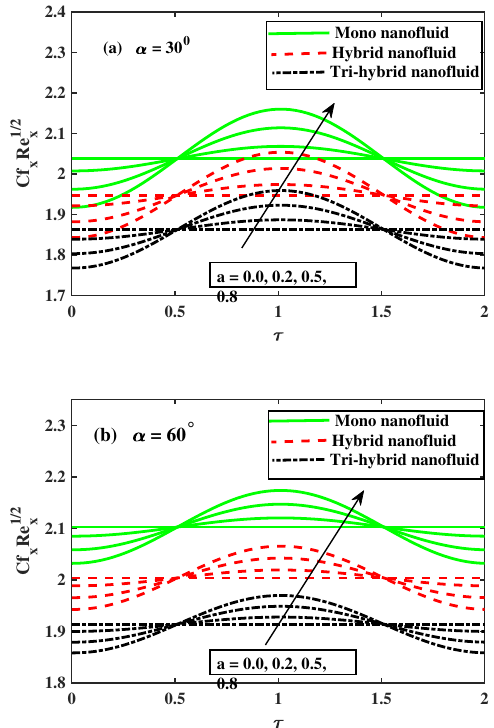
Figure 6. ( a ) Fluctuation of α on Cf x Re 1/2 x ; ( b ) Fluctuation of α on Cf x Re 1/2 x